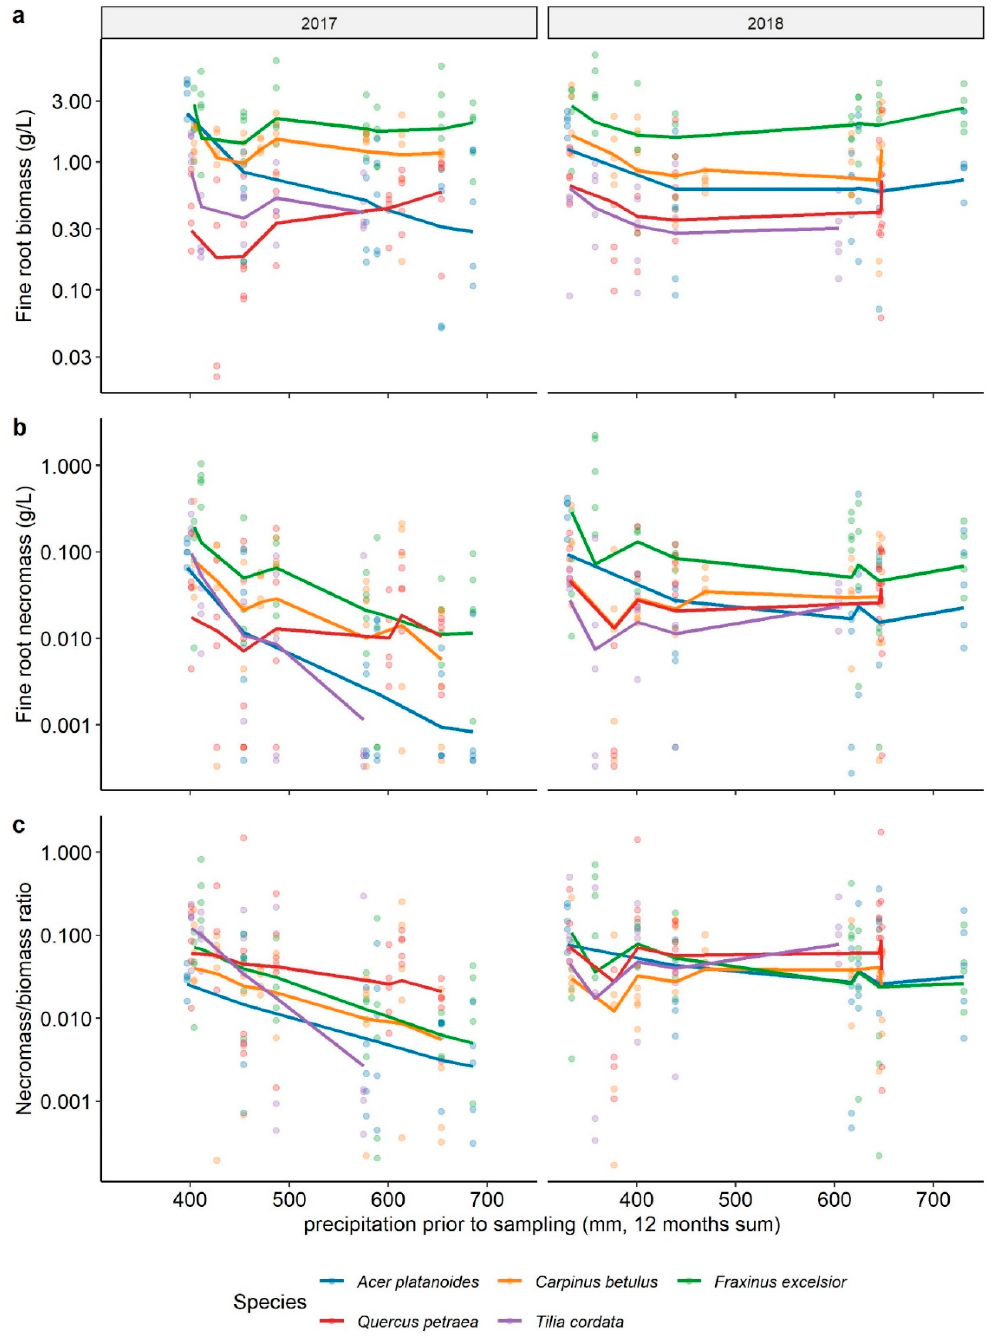
Figure A1. Fine root biomass ( a ), necromass ( b ) and necromass / biomass ratio ( c ) in the topsoil (0–10 cm) of the five species in relation to actual precipitation in the year prior to sampling in the 2017 and 2018 inventories. Data points are tree-level values, lines represent conditional predictions of the linear mixed e ff ects model (the predictions of the fixed e ff ect “MAP” for each species plus an intercept for each level of the random factor “site”). Note the log-scaled y-axis. The corresponding p and pseudo-R 2 values are summarized in Table A1.